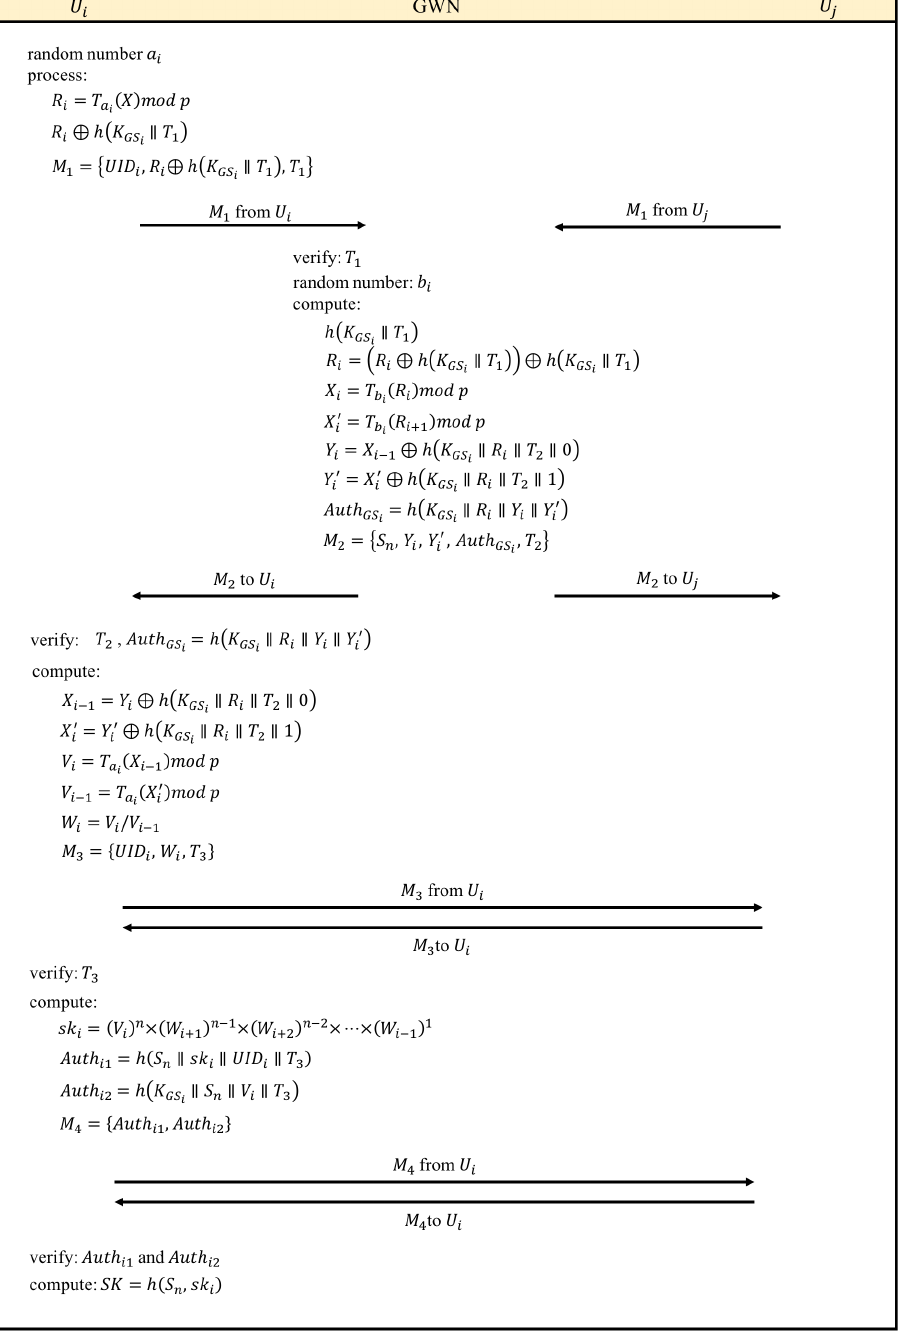
Figure 3. The authentication